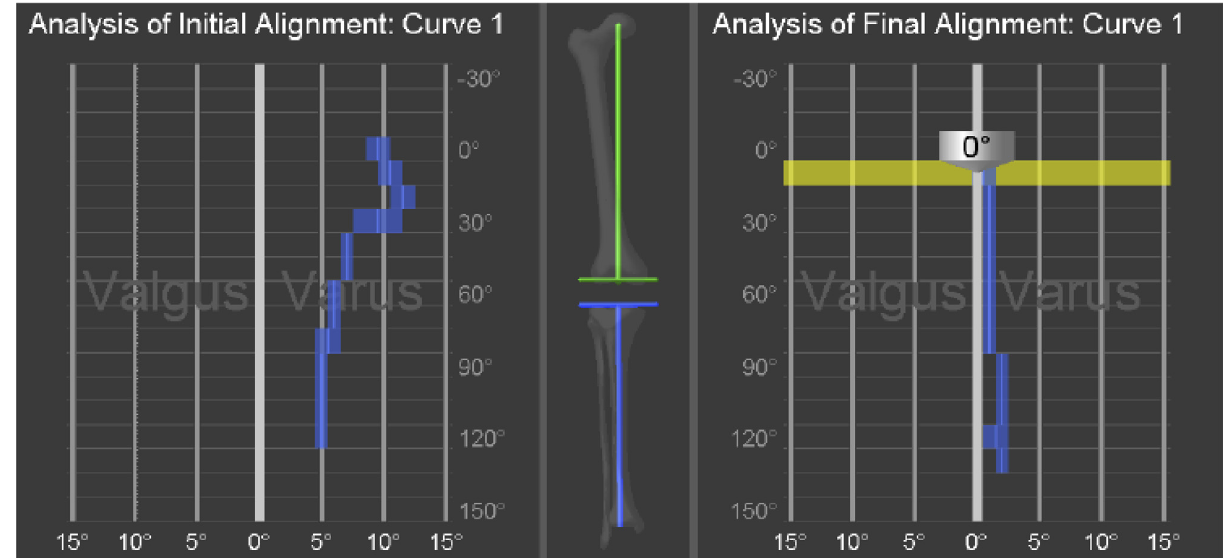
Figure 2. The change in coronal deformity ( X axis) of knee femoro-tibial mechanical alignment angle, as the knee flexes ( Y axis): first part showing before the surgery valgus deformity first increases and then decreases as the knee flexes (Type 4A in Deep’s classification) and second part showing the axis achieved after surgery of same patient (Neutral alignment).